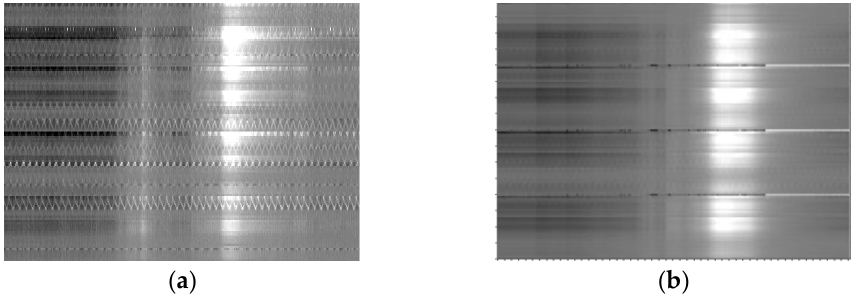
Figure 2. Results of channel normalization. ( a ) Before channel normalization; ( b ) after channel normalization.